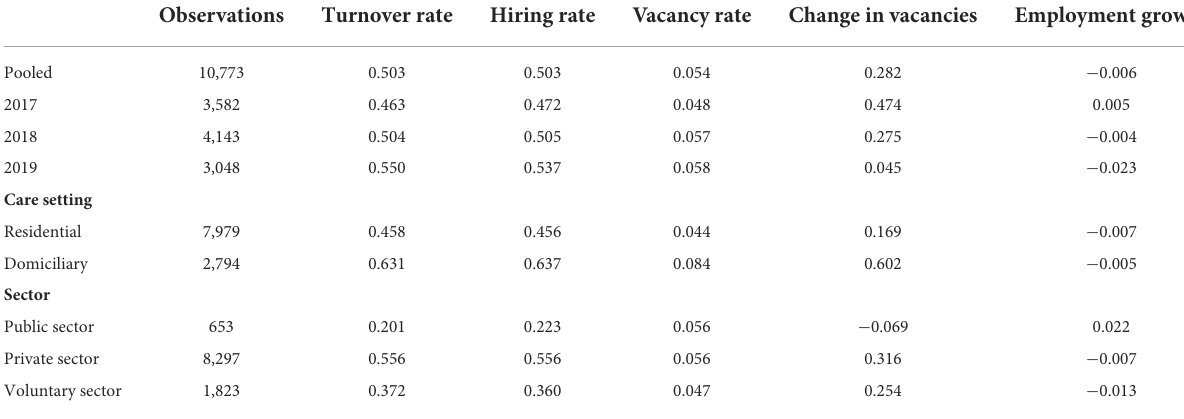
TABLE 2 Worker flows and vacancies across years, care settings and